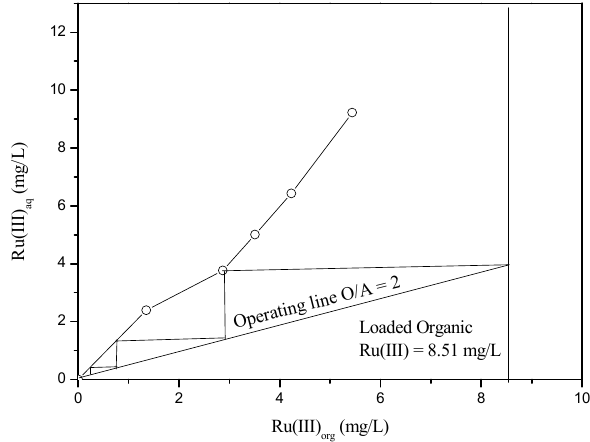
Figure 6. McCabe-Thiele diagram for the stripping of Ru(III) from the loaded Aliquat 336 by 0.1 M HCl.